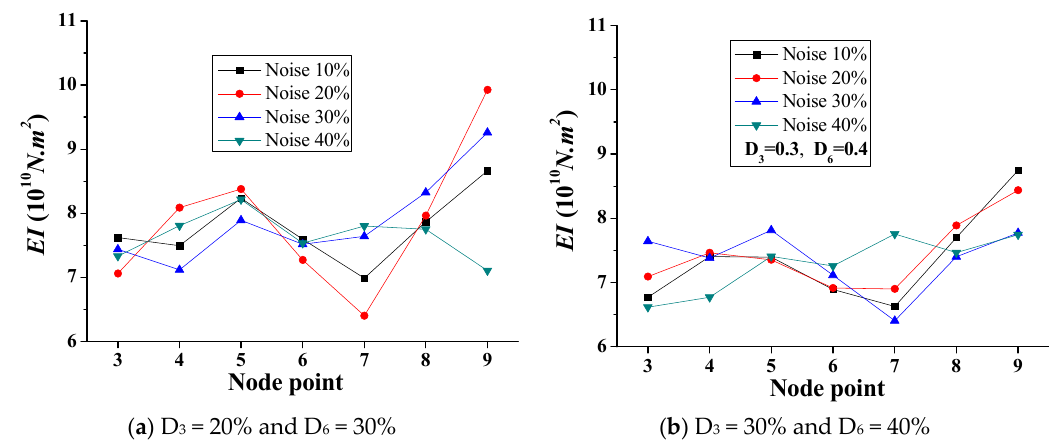
Figure 18. Simulation results of calculated EI with different noise levels (Scenario 2).